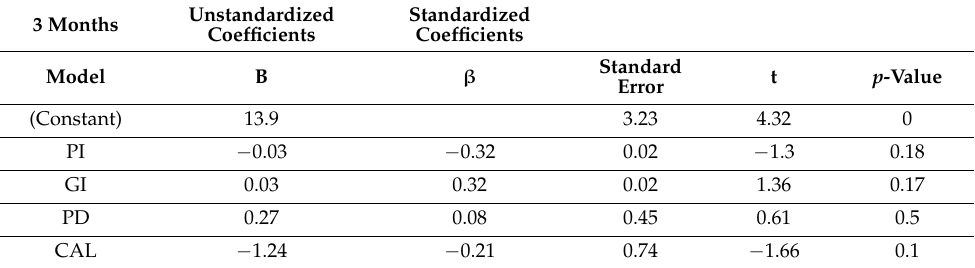
Table 7. The individual predictors.